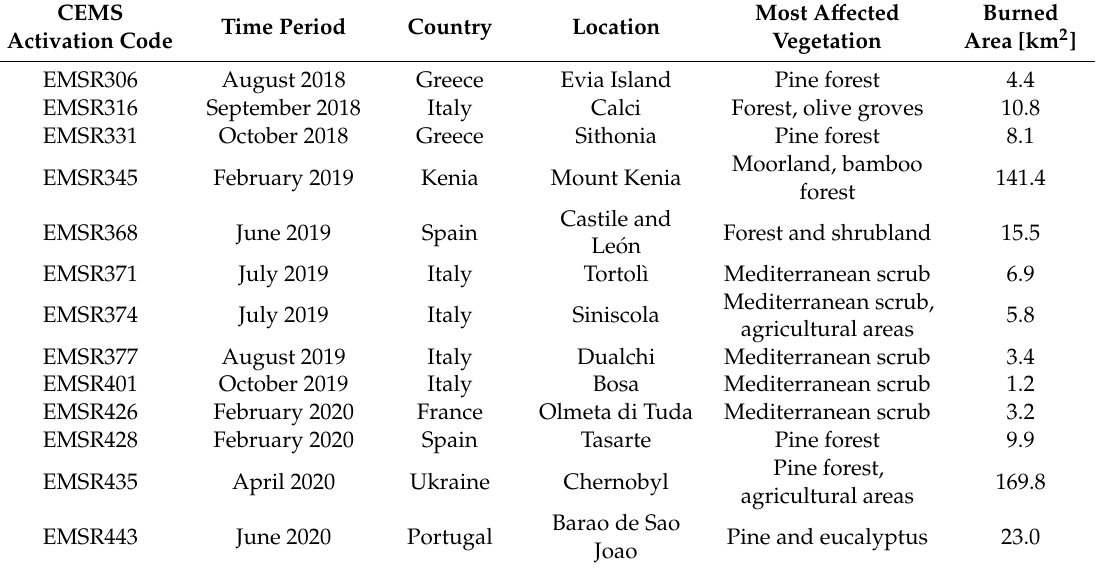
Table 2. Test cases considered in this study for BA mapping.